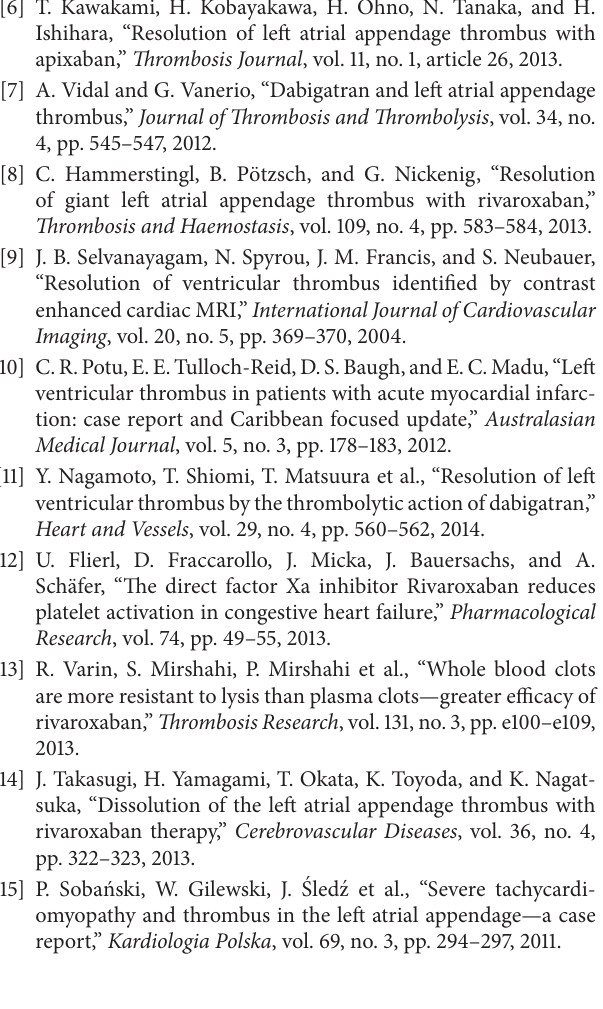
not perform contrast enhanced CT or head MRI to confirm the absence of additional embolism after the disappearance of LV thrombus with